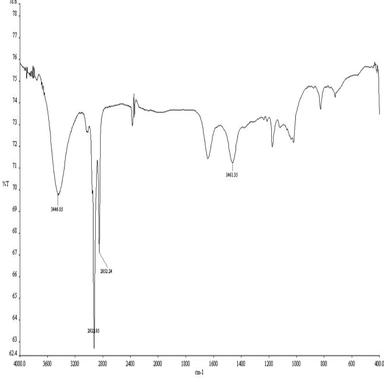
FTIR spectrum of pure DMPI (Product).